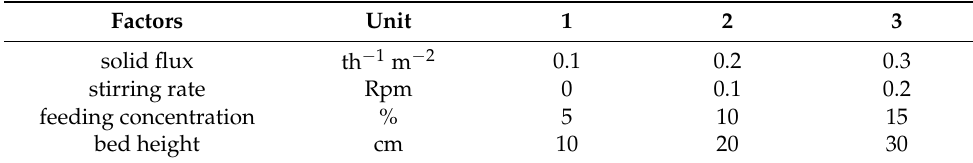
Table 2. Experimental factors and level selection .